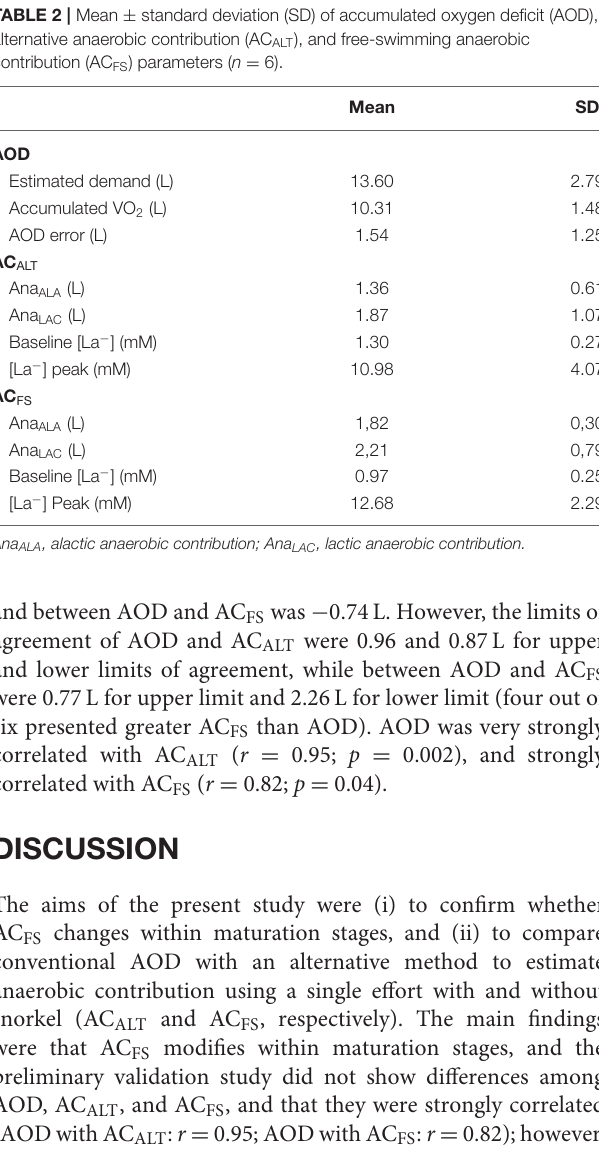
TABLE 1 | Mean and standard deviation of age, height, weight, total muscle mass (TMM), total body fat (TBF), peak oxygen consumption (VO 2Peak ), baseline lactate